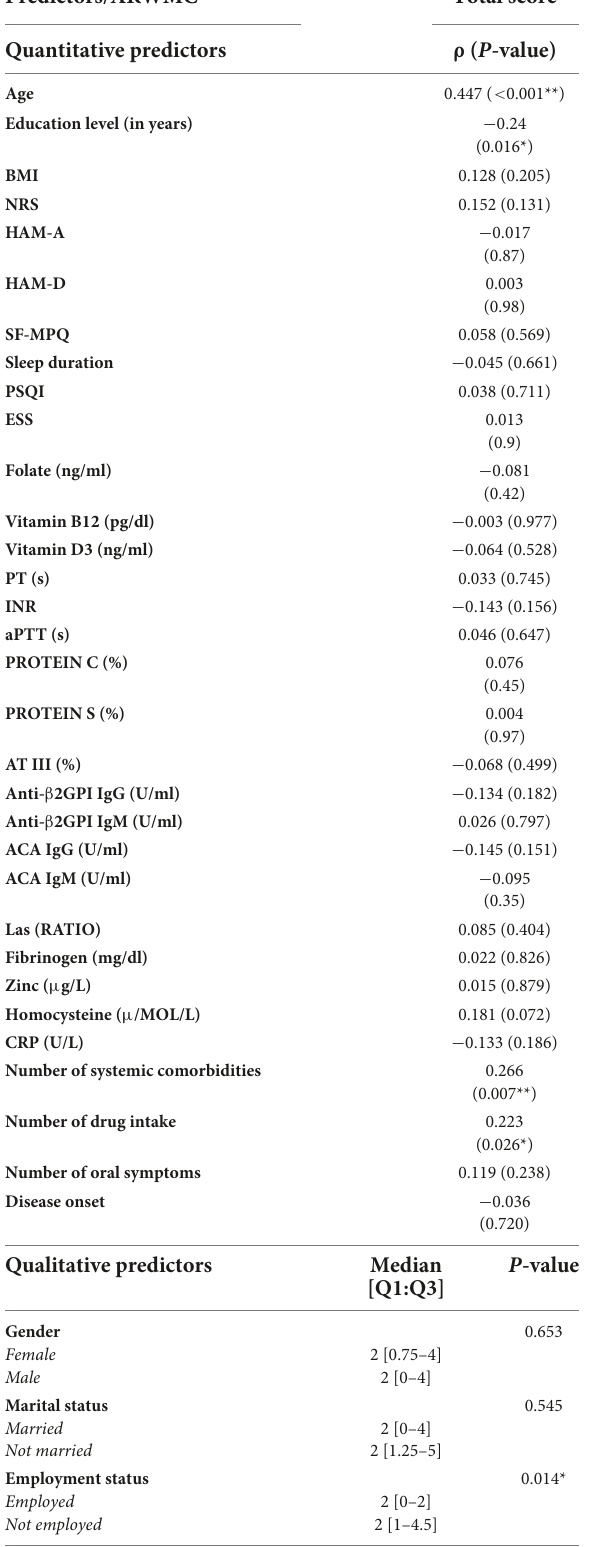
TABLE 5 Linear correlation analysis between the total ARWMC score and the quantitative/qualitative predictors in BMS patients. Predictors/ARWMC